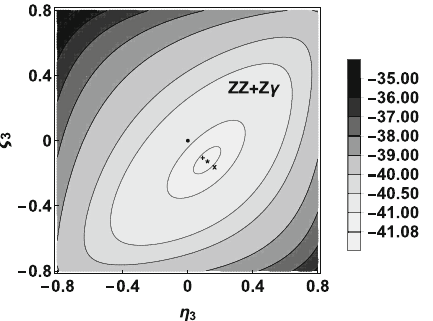
Fig. 7 The log of average likelihood, log [ L ( V { f , h } , { O }; η 3 ,ξ 3 ) ] , is √ s = 500 GeV, shown considering both processes Z Z and Z γ at = ( + 0 . 12 , − 0 . 12 ) is the L = 100 fb − 1 . The asterisk mark at P best combined best choice for beam polarizations, while the other points are for Z Z ( cross mark ) and Z γ ( plus mark )